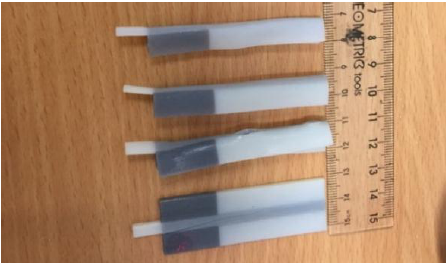
Figure 34. Folding line 2. Materials 2018 , 11 , x FOR PEER REVIEW